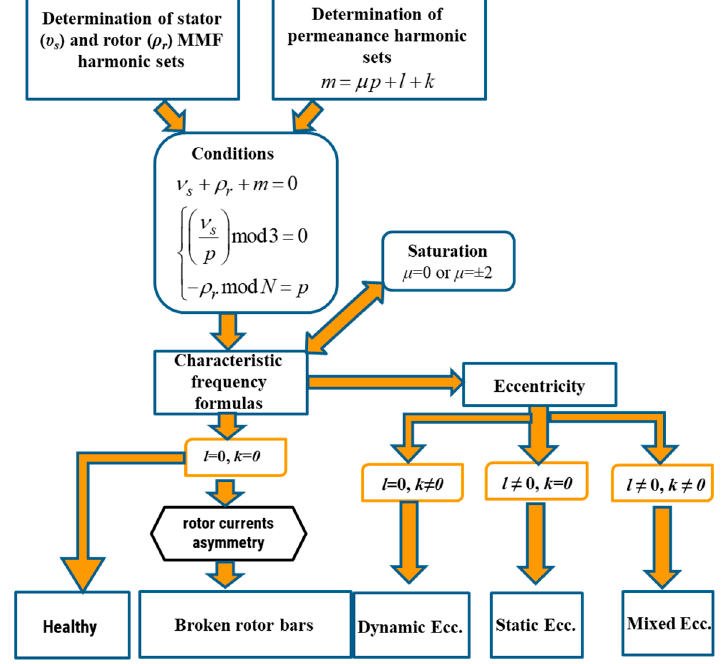
Figure 8. Algorithm of the characteristic frequency derived for known p and N .